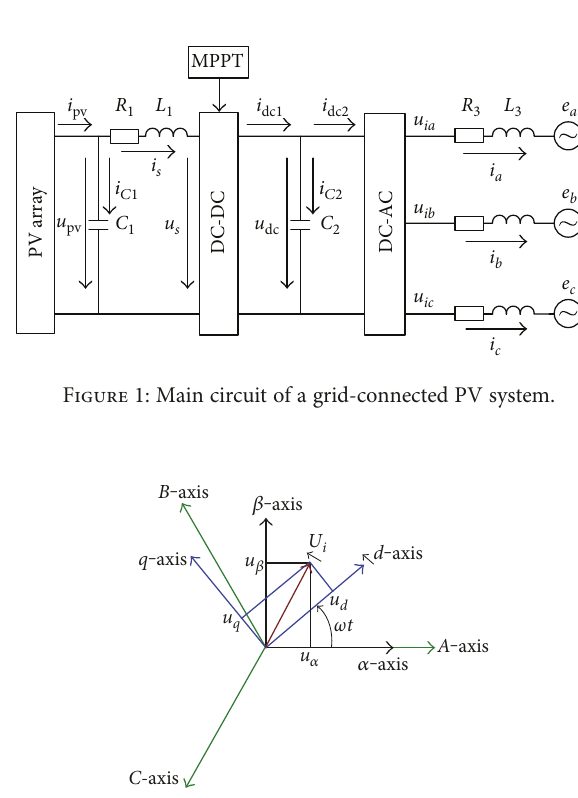
Figure 2: Reference